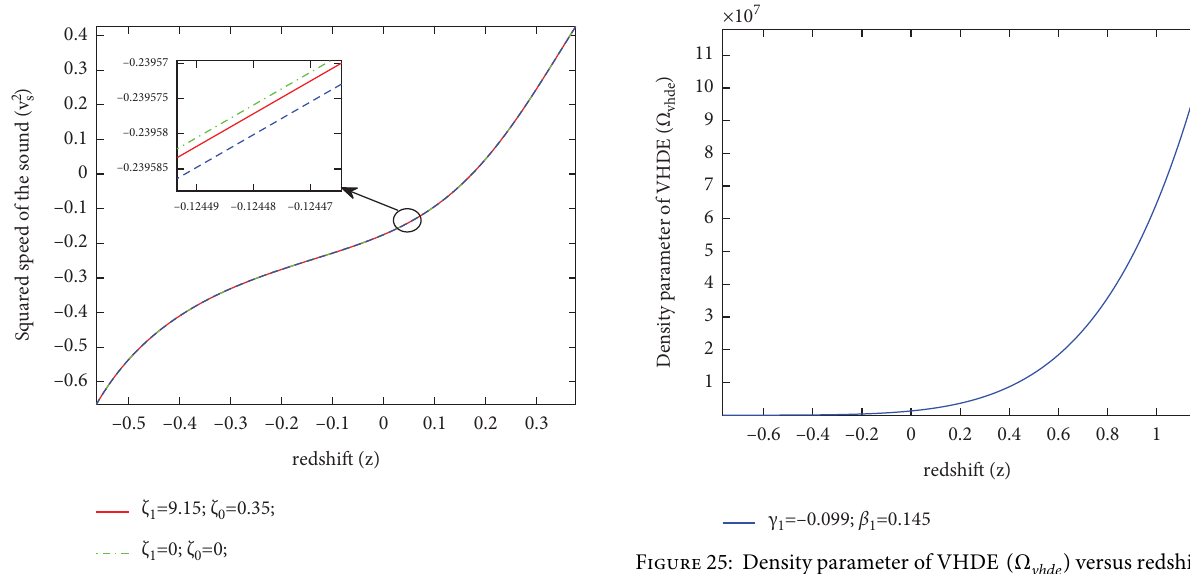
vhde ) versus redshift ( z )